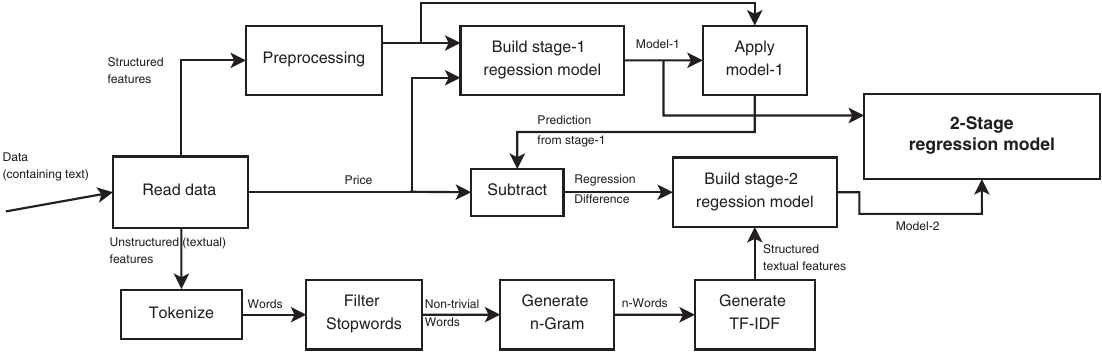
Figure 1: The Data Mining Process We Used to Build the Two-Stage Regression Model. The first stage attempts to predict the target attribute using only the simple features. The second stage attempts to predict the difference between the actual value of the target attribute and the initial prediction from Stage